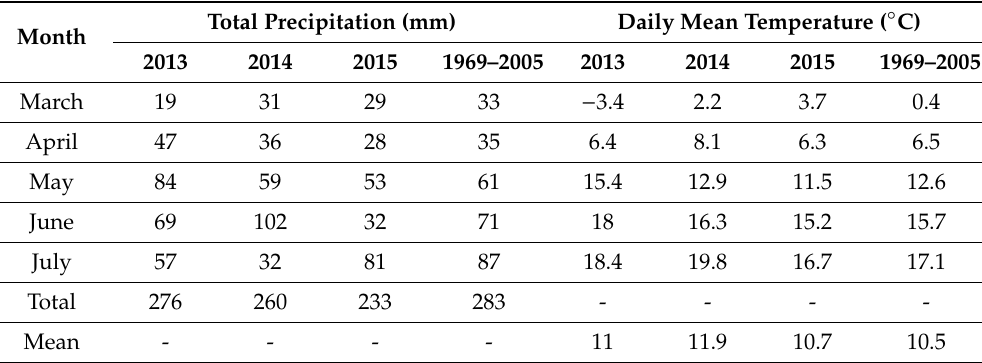
Table 3. Meteorological conditions in 2013–2015 compared to the long-term